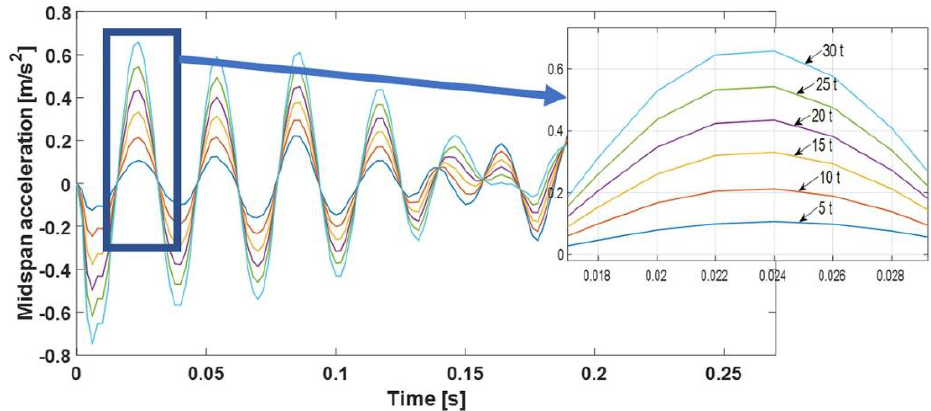
Figure 2. Bridge mid-span first-peak acceleration responses for single quarter-cars with different masses (the same road profile is used in each run of the general road profile).